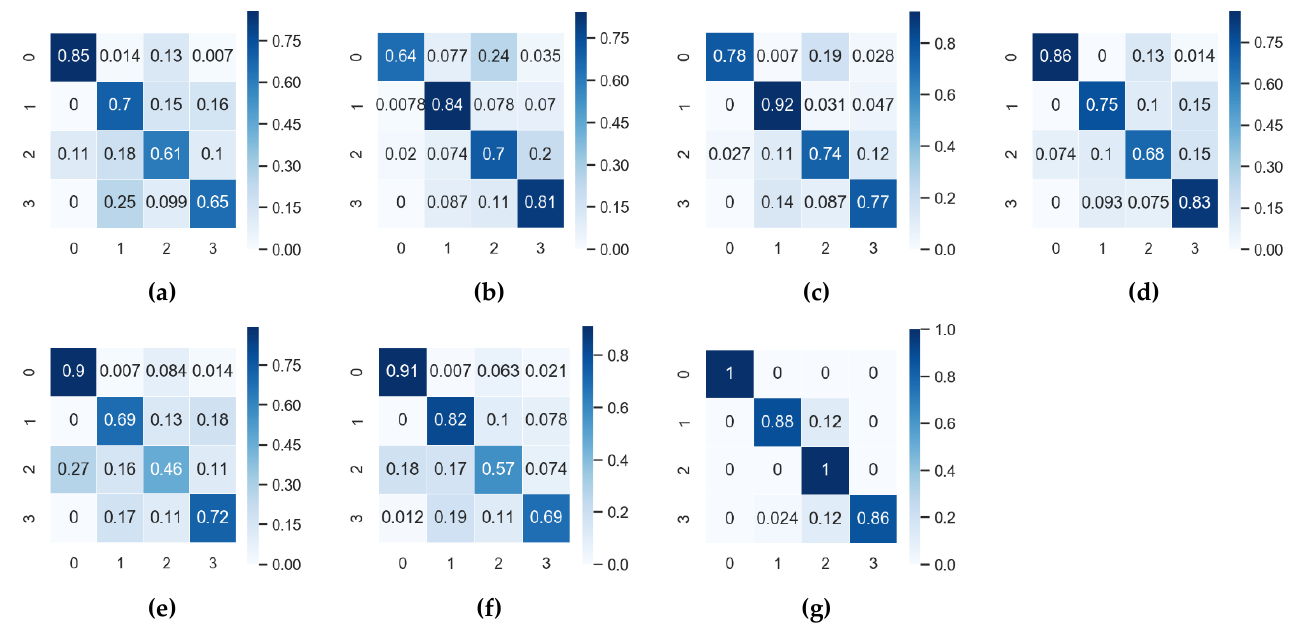
( b ) Figure 7. Performance Evaluation of ( a ) 2018/5/11 and ( b ) 2018/7/14 . As for the validation, as there is no label about which performance stage the PV sys- tem is in and which fault it suffers (which makes it difficult to conduct detailed verifica- tion and give specific classification metrics), we have manually labelled the data and conducted classification experiments to verify the performance of our method compared with other advanced machine learning classification algorithms. The input of classifica- tion models are the monitoring records that include both meteorological data as listed in (2) and corresponding generated PV power data. The output of classification models in- dicates which performance period the PV system is in, i.e., malfunction, ideal, transition, or downturn periods. We compare our method with several widely-used and powerful algorithms under their classification implementations, i.e., support vector machine clas- sification [46–48] with linear kernel (SVC-Linear), support vector machine classification with RBF (SVC-RBF), decision tree classification (DTC) [49], random forest classification